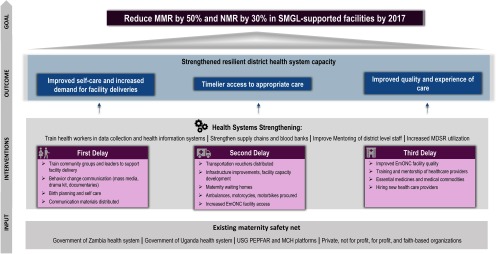
Saving Mothers, Giving Life Theory of Change ModelAbbreviations: EmONC, emergency obstetric and newborn care; MCH, maternal and child health; MPDSR, maternal and perinatal death surveillance and response; MMR, maternal mortality ratio; NMR, neonatal mortality rate; PEPFAR, U.S. President's Emergency Plan for AIDS Relief; SMGL, Saving Mothers, Giving Life; USG, U.S. Government.Source: Adapted from Saving Mothers, Giving Life.57